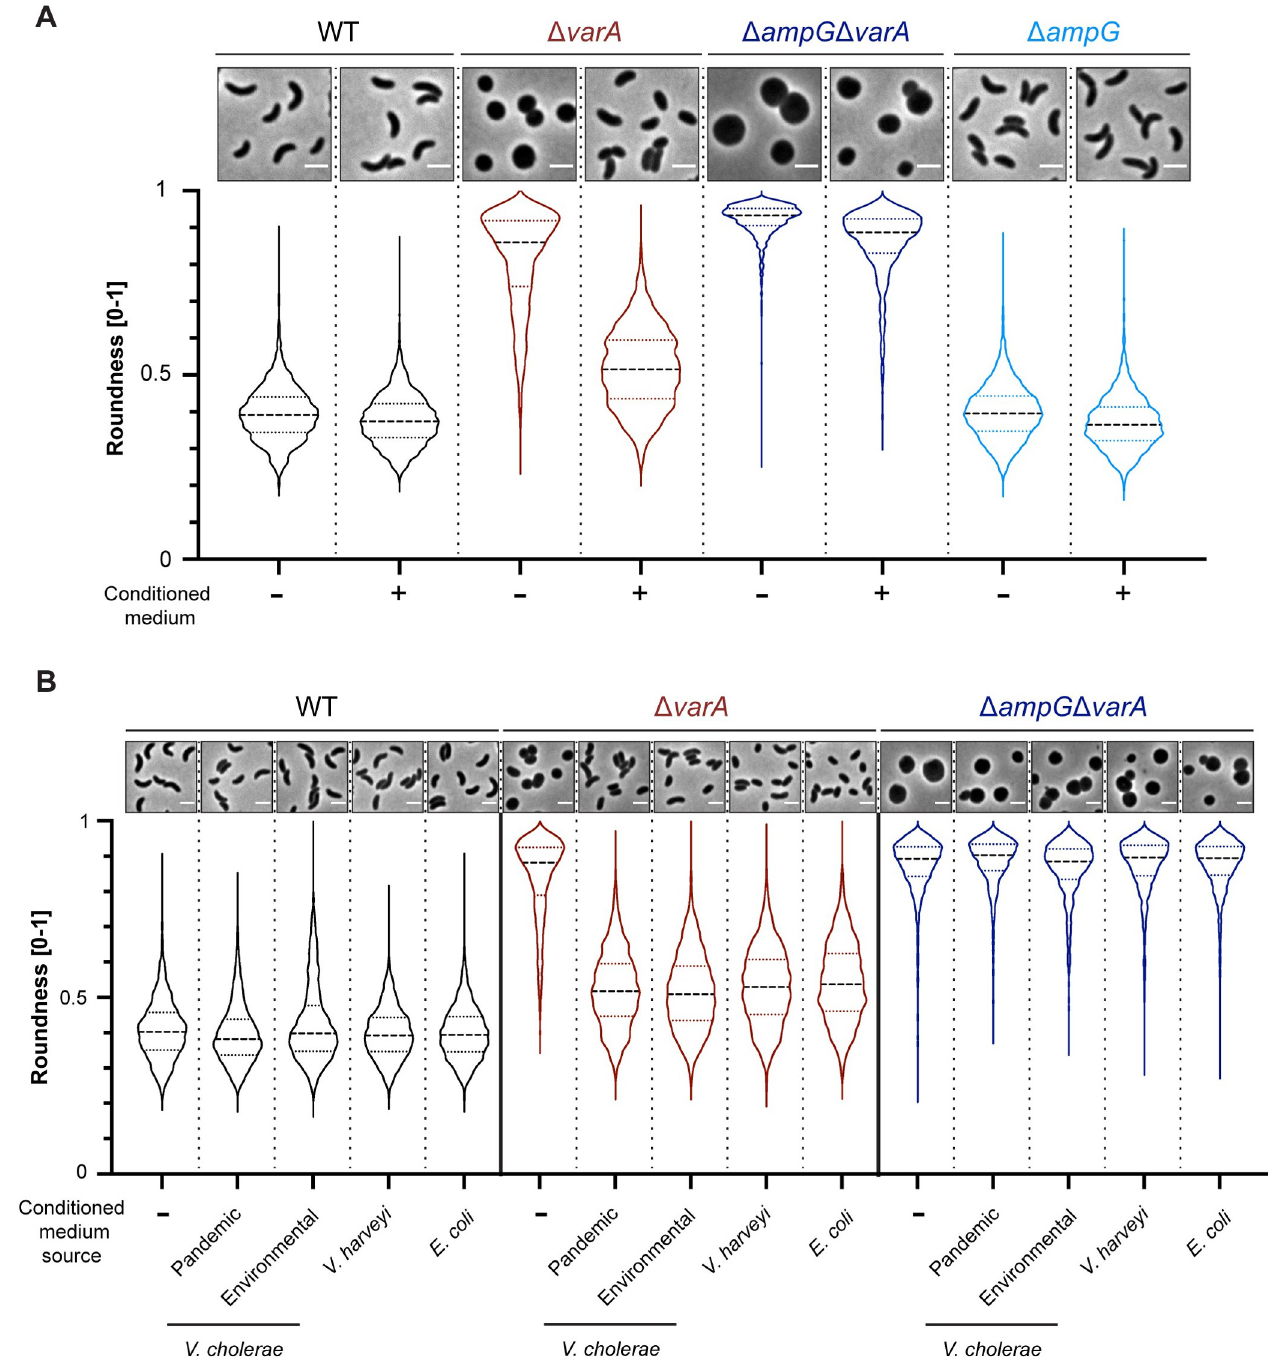
Fig 3. Recycling of PG prevents rounding of Δ varA cells. (A) Conditioned medium rescues the Vibrio shape of Δ varA in an AmpG-dependent manner. Phase contrast micrographs (top) and shape quantification (bottom) of the WT, Δ varA , Δ ampG Δ varA , and Δ ampG strains grown in the absence (-) or presence (+) of conditioned medium. Scale bar: 2 μ m. The quantification of roundness was performed with 3000 cells (n = 1000 per biologically independent experiment) using the MicrobeJ software. Roundness values range from 0 to 1. (B) Conditioned medium of diverse gram-negative bacteria rescues the Δ varA rounding phenotype. Conditioned medium was derived from pandemic V . cholerae A1552 or environmental V . cholerae SA5Y, V . harveyi , or E . coli . Details as in panel A.